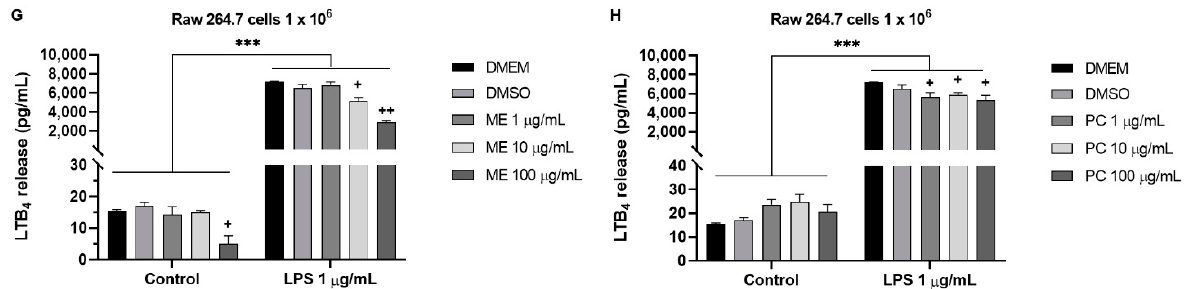
Figure 5. The effect of ME and PC on LPS-induced NO, IL-6, PGE 2 , and LTB 4 release from cultured RAW 264.7 cells. Several concentrations (1, 10, or 100 µg/mL) of ME or PC were added into the media 1 h prior to LPS treatment. NO ( A , B ), IL-6 ( C , D ), PGE 2 ( E , F ), and LTB 4 ( G , H ) levels in the medium were measured after RAW cells were incubated with LPS for 24 h. The vertical bars indicate the mean ± SD ( n = 3). NO release: ( A ) Control vs. LPS 1 µg/mL p = 0.0039, DMSO vs. ME 100 µg/mL p = 0.0097; ( B ) Control vs. LPS 1 µg/mL p = 0.0048, DMSO VS. PC 10 µg/mL p = 0.0366, DMSO VS. PC 100 µg/mL p = 0.0437. IL-6 release: ( C ) Control vs. LPS 1 µg/mL p = 0.0001, DMSO vs. ME 100 µg/mL p = 0.0166; ( D ) Control vs. LPS 1 µg/mL p < 0.0001, DMSO VS. PC 100 µg/mL p = 0.0173. PGE 2 release: ( E ) Control vs. LPS 1 µg/mL p = 0.0024, DMSO vs.